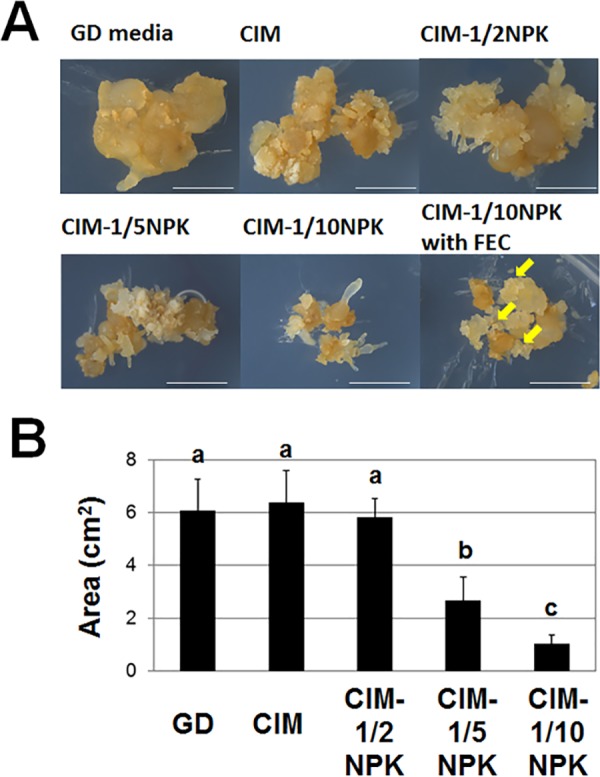
Growth of non-FEC on nitrogen, phosphate, and potassium reduced media.A) SE cultured on DKW media were grown on GD, CIM, CIM with reduced contents of nitrogen, phosphate, and potassium (CIM-½ NPK CIM-⅕ NPK, and CIM-Ρ NPK) for 3 weeks. Scale bar = 5 mm. Yellow arrows on the photo of CIM-Ρ NPK with FEC indicated the formation of FEC, B) growth area (i.e., the portion of space occupied by the callus) of the non-FEC pictured in Fig 2A was estimated after three weeks of culture. Data represent the mean ± SD as triplicate independent measurements with 10 biological replicates. Values labeled with different letters (a, b and c) at all conditions are significantly different by Scheff’s multiple comparison tests at P<0.05.